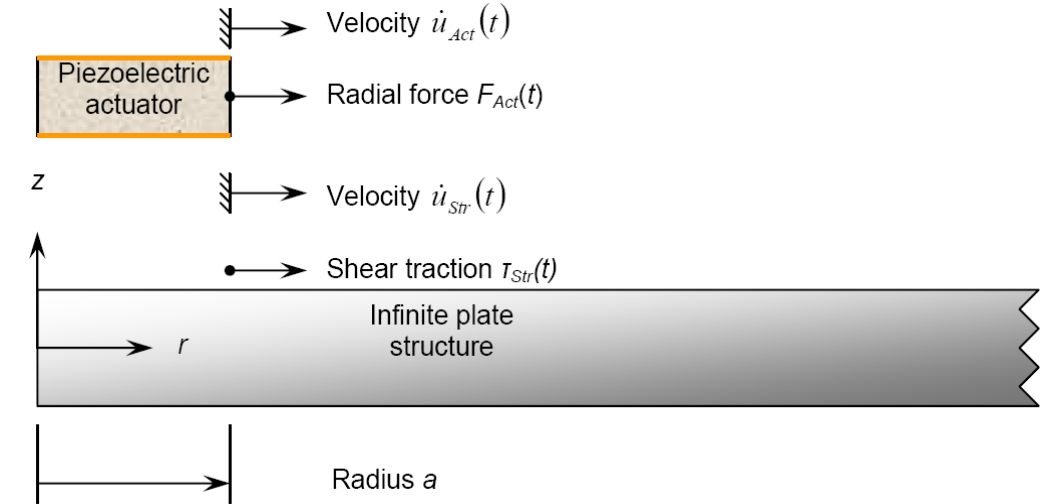
Figure 3. Free body diagram of the actuator/host structural system. Taken from Dunn et al.